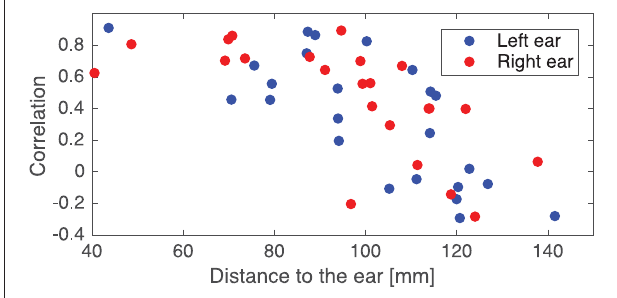
FIGURE 9 | Scatter plot showing the relationship between the Pearson’s correlation coefficient and the distance from the source to the left or right ear. The location of an ear was calculated as the average of the ear electrode locations in that ear. The plot is based on the ICs in Figure 8